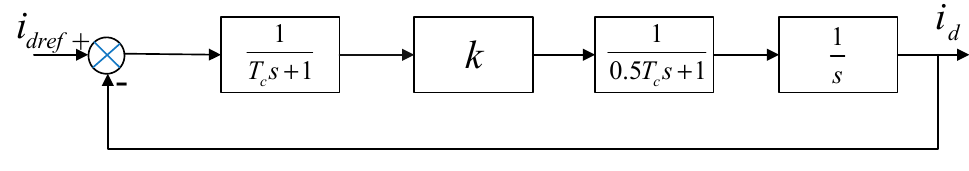
Figure 4. Dynamic block diagram of the current loop.